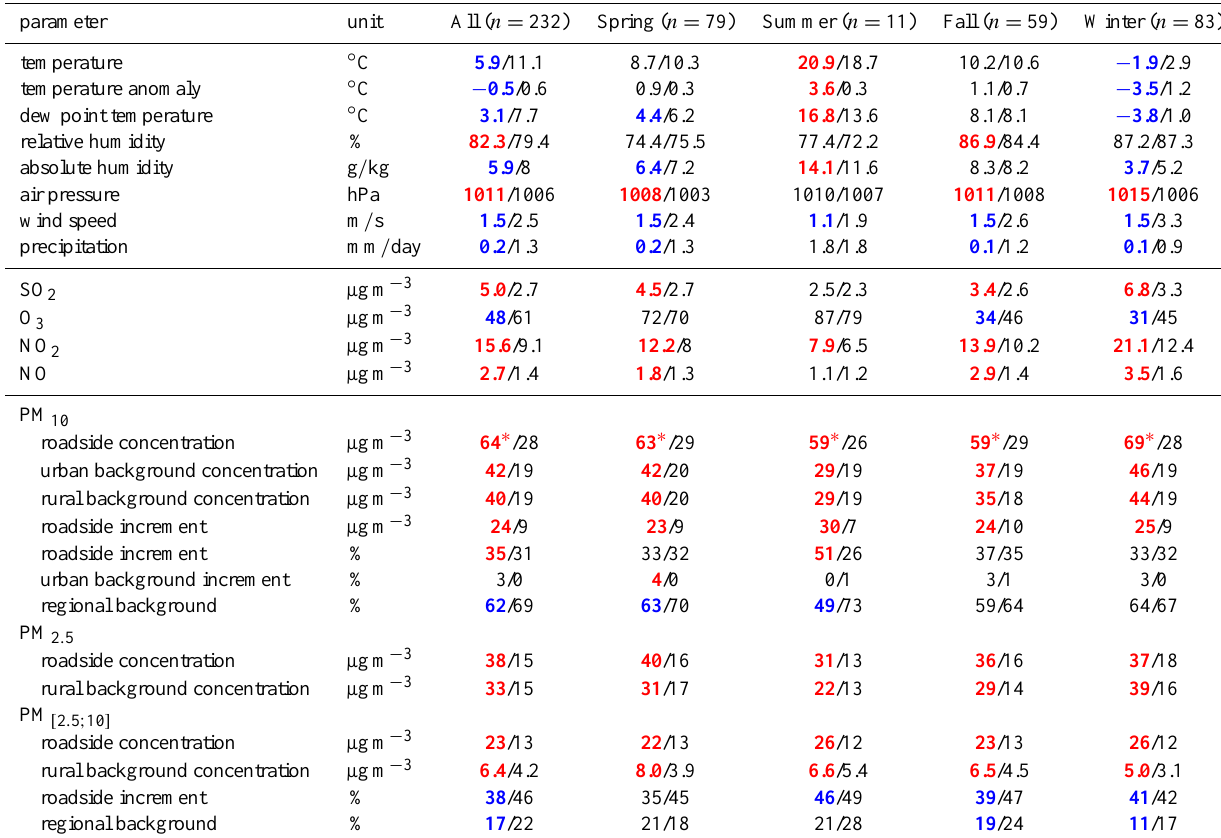
Table 3. Characteristics of exceedance days (left numbers, also indicated by n ) compared to non-exeedance days (right numbers). Bold face indicates a significant difference in the Whitney-Mann-U test on the confidence level α = 0 . 95. The tests were made for the total data set and all four seasons individually. Red face indicates significantly higher values, blue face significantly lower values. The temperature anomaly was calculated as the daily mean temperature minus the climatological average temperature for that day of the